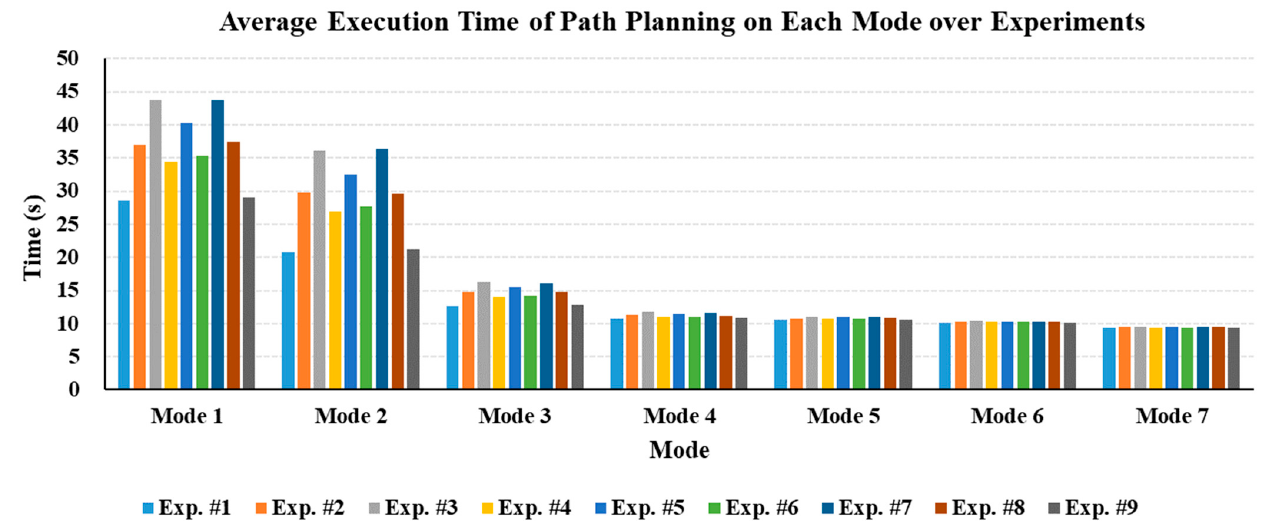
Figure 29. Average execution time of each mode running in all scene layouts over the experiments.